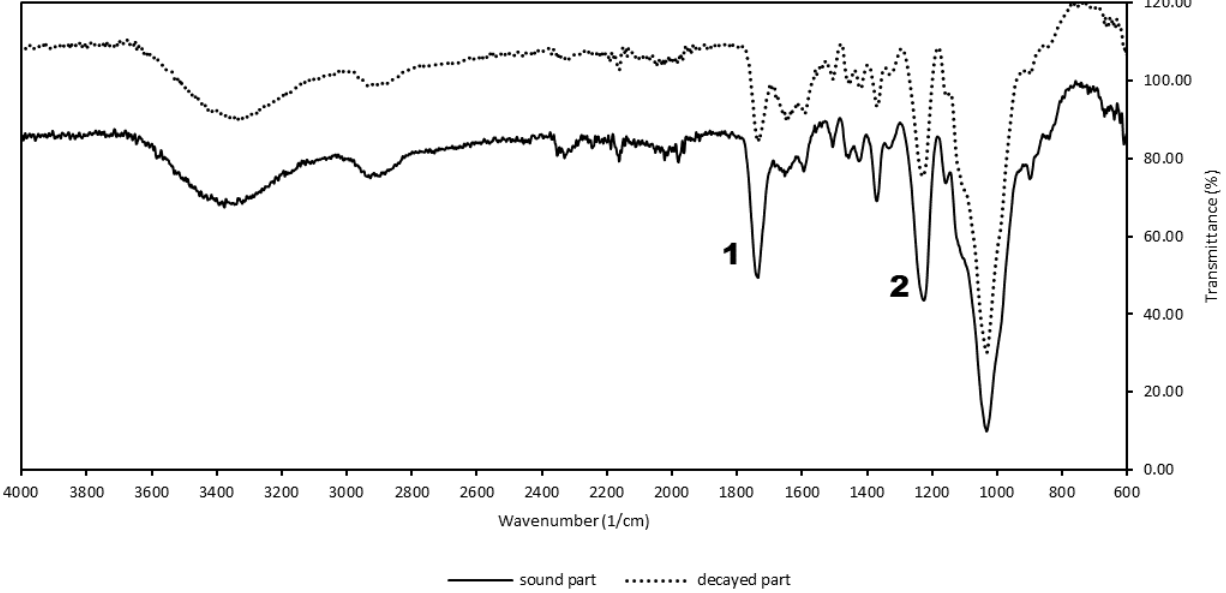
Figure 9. FTIR spectra of acetylated hornbeam wood powder with initial decay (dotted line) and no visible decay (solid line).